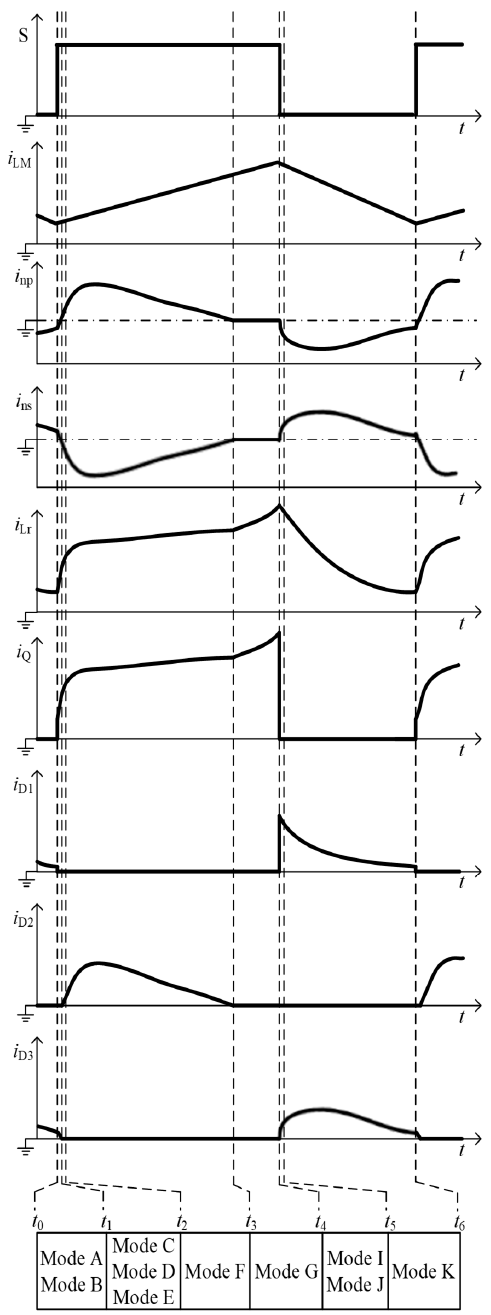
Figure 3. The simplified current waveforms of the converter. Mode A: End with i C3 dropping to 0; Mode B: End with i D3 dropping to 0; Mode C: End with i C4 dropping to 0; Mode D: End with i C1 equaling i D2 ; Mode E: End with i C1 dropping to 0; Mode I: End with i C3 dropping to 0; Mode J: End with i C1 dropping to 0.